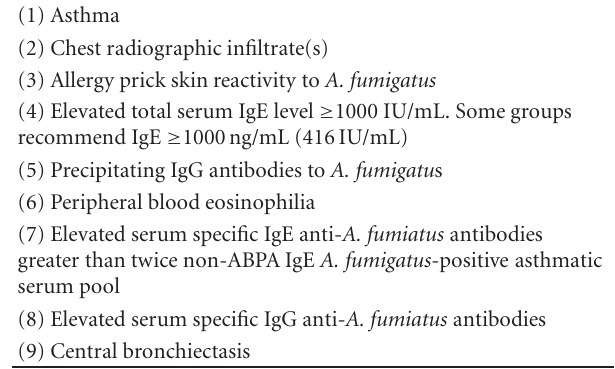
Table 2: Criteria for diagnosis of allergic bronchopulmonary aspergillosis in cystic